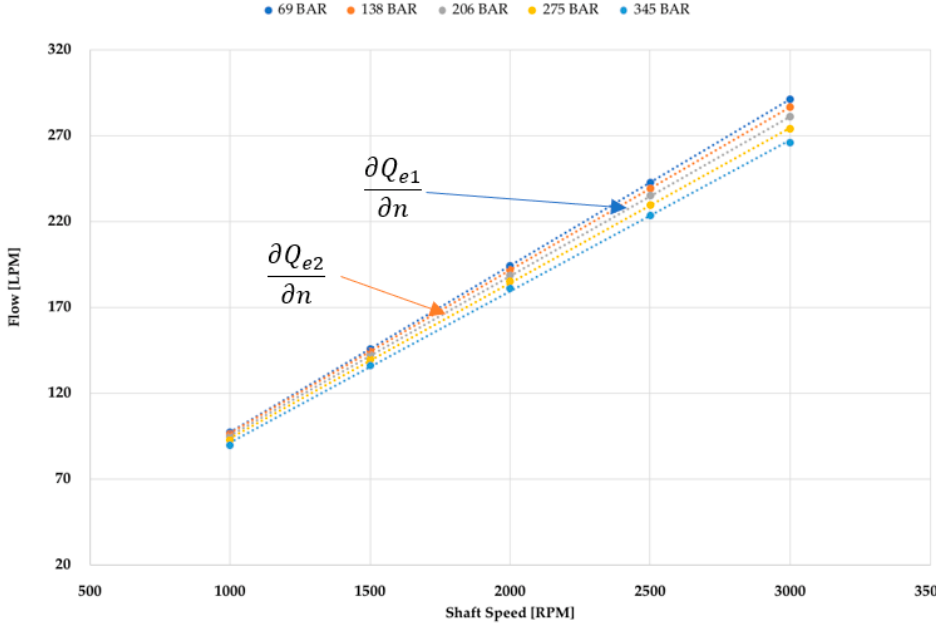
Figure 2. First step for estimating the derived displacement using this method.